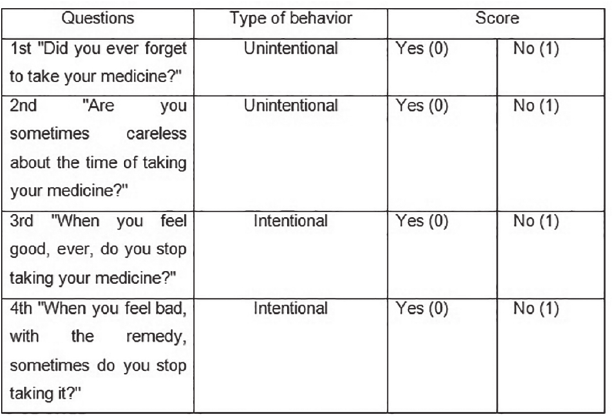
FIGURE 1 - Questions that make up the MGT and classification regarding the intention of the types of low adherence behavior (Adapted from Morisky, Green, Levine,